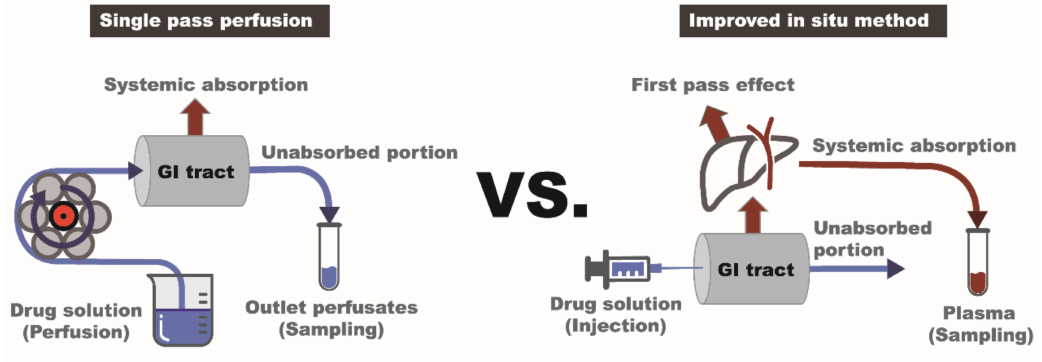
Figure 1. Schematic diagram of the experimental set-ups for the single-pass perfusion method and the improved in situ absorption method. While a drug solution is perfused and an outlet perfusate is sampled for the assessment of absorption in the single-pass perfusion ( left ); a drug solution is injected into the gastrointestinal segment and plasma samples are used to assess the systemic absorption of a drug in the improved in situ method ( right